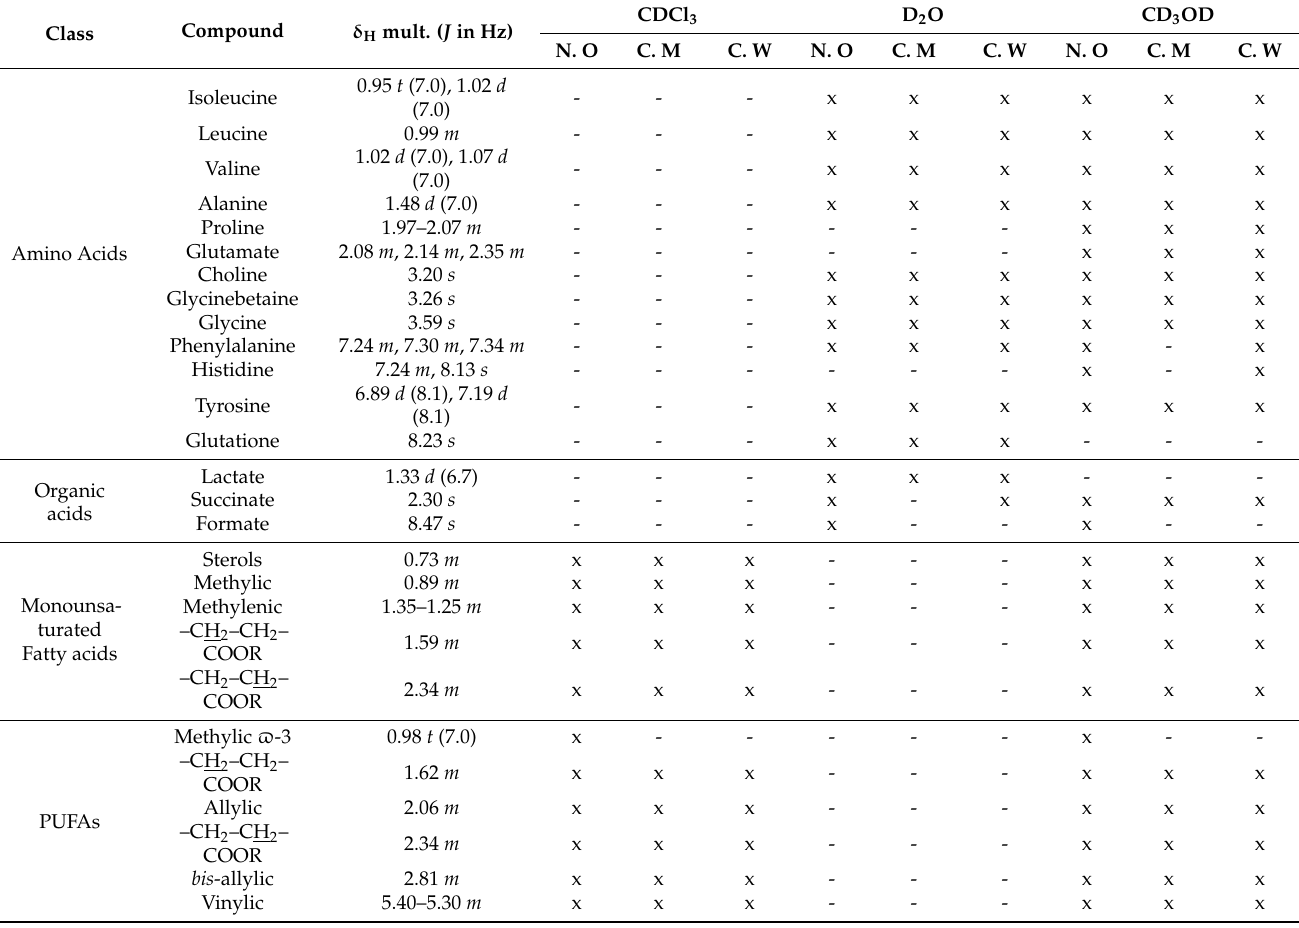
Table 1. Assignment of main resonances of marine microalgae by 1 H HR-MAS NMR (400